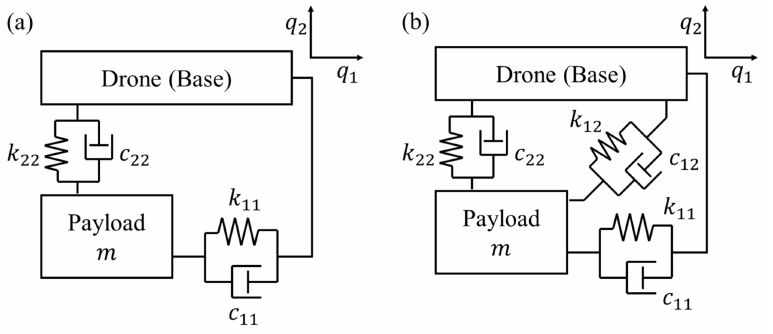
Figure 1. A free body diagram of ( a ) general and ( b ) coupled two-degree-of-freedom